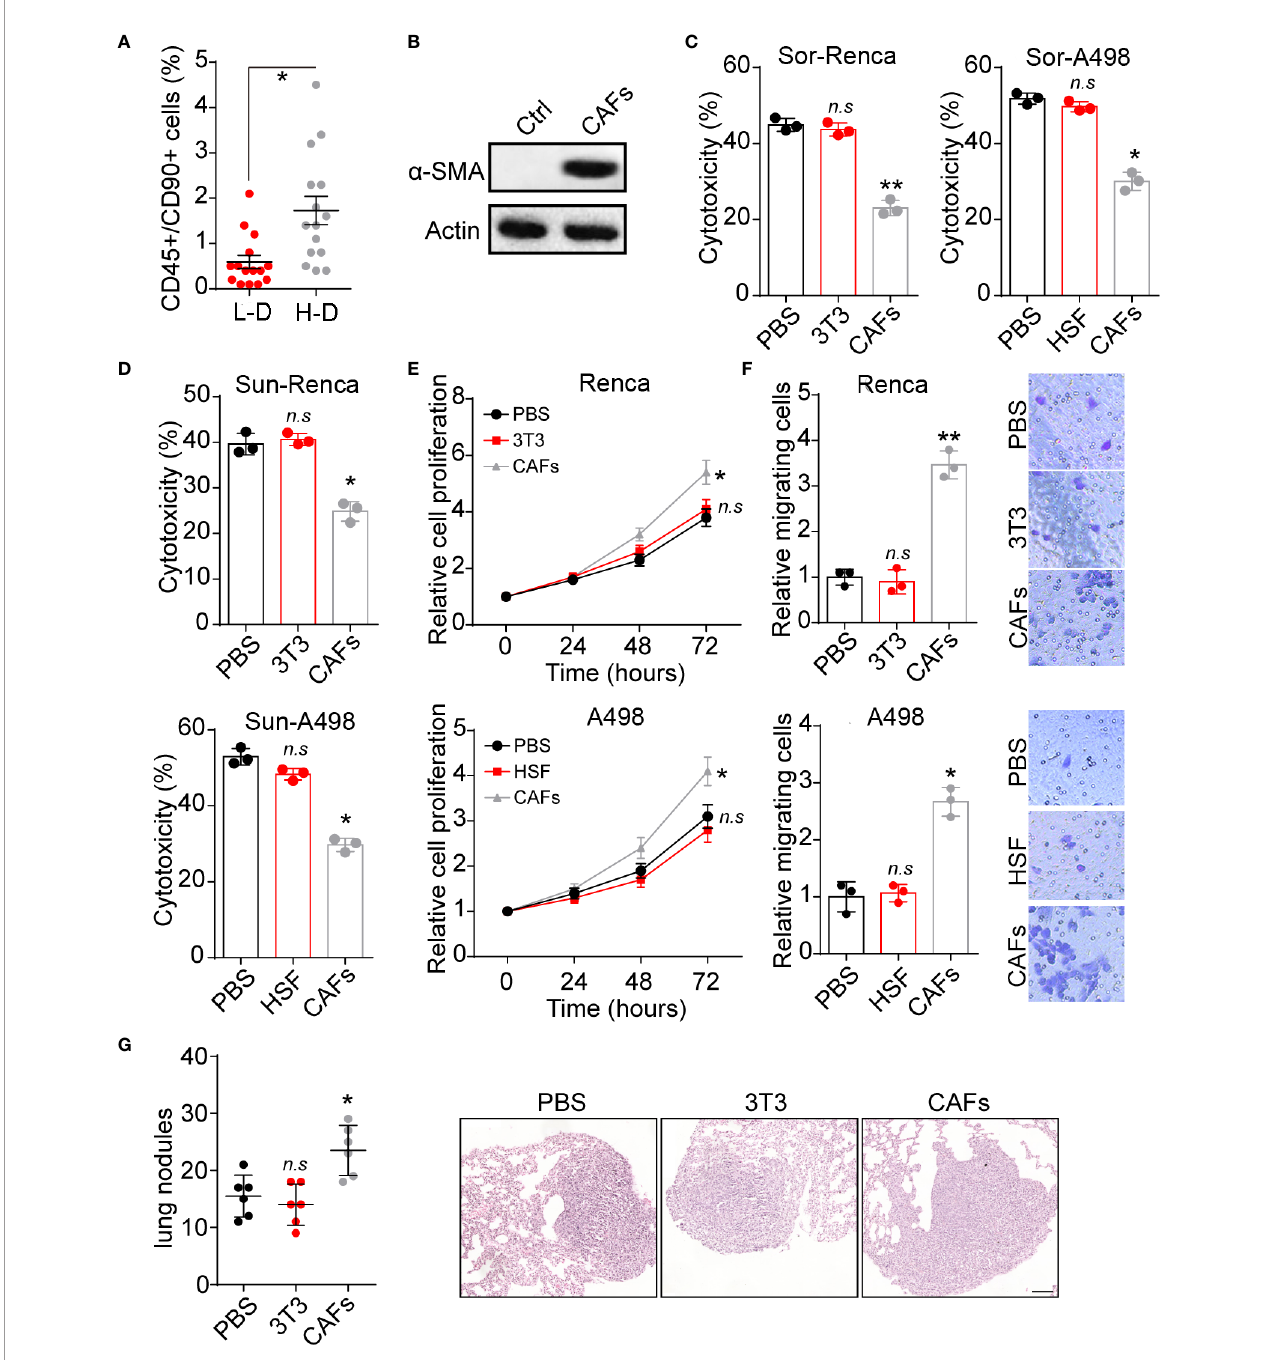
FIGURE 1 | CAFs promoted renal cancer progression. (A) The percentage of CD45+/CD90+ cells subpopulation in tumor tissues from high degree (H-D) and low degree (L-D) malignant renal patients (n=15). (B) The western blotting of a -SMA in tumor tissues (ctrl) and CAFs isolated from tumor tissues of renal patients. (C) The cytotoxicity of Sor to Renca/A498 co-cultured with NIH-3T3, HSF or CAFs. (D) The cytotoxicity of Sun to Renca/A498 co-cultured with NIH-3T3, HSF or CAFs. (E) The relative cells proliferation of Renca/A498 co-cultured with NIH-3T3, HSF or CAFs. (F) The relative migrating cells numbers and representative images of Renca/A498 co-cultured with NIH-3T3, HSF or CAFs by transwell. (G) The lung nodules numbers and representative images of Renca lung metastasis mice models. Renca cells were co-cultured with NIH-3T3 or CAFs and 10 6 Renca were injected into BalB/C mice by tail vein, which were sacri fi ced on day 20. The scale bar is 200 m m. Mean ± SEM, n.s, no signi fi cant difference; *p < 0.05, **p <